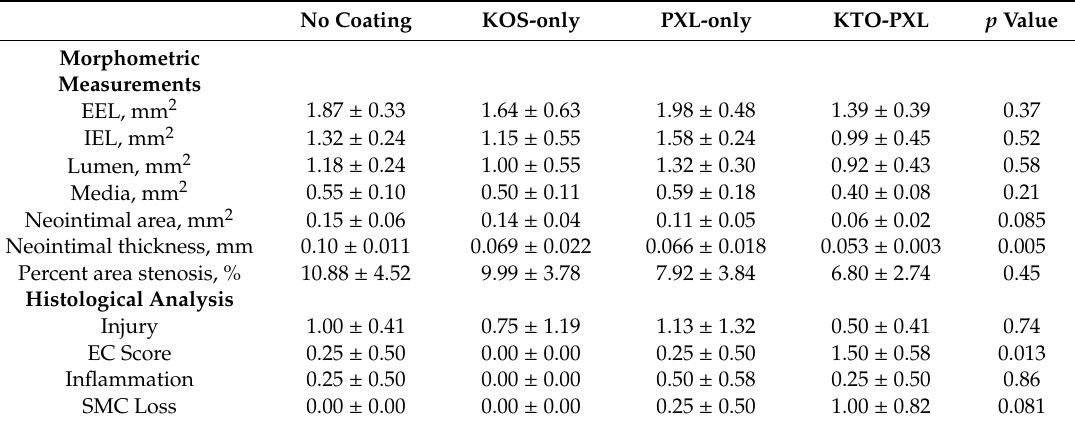
Table 2. Summary of the morphometric and histological measurements in the rabbit iliac–femoral injury model.